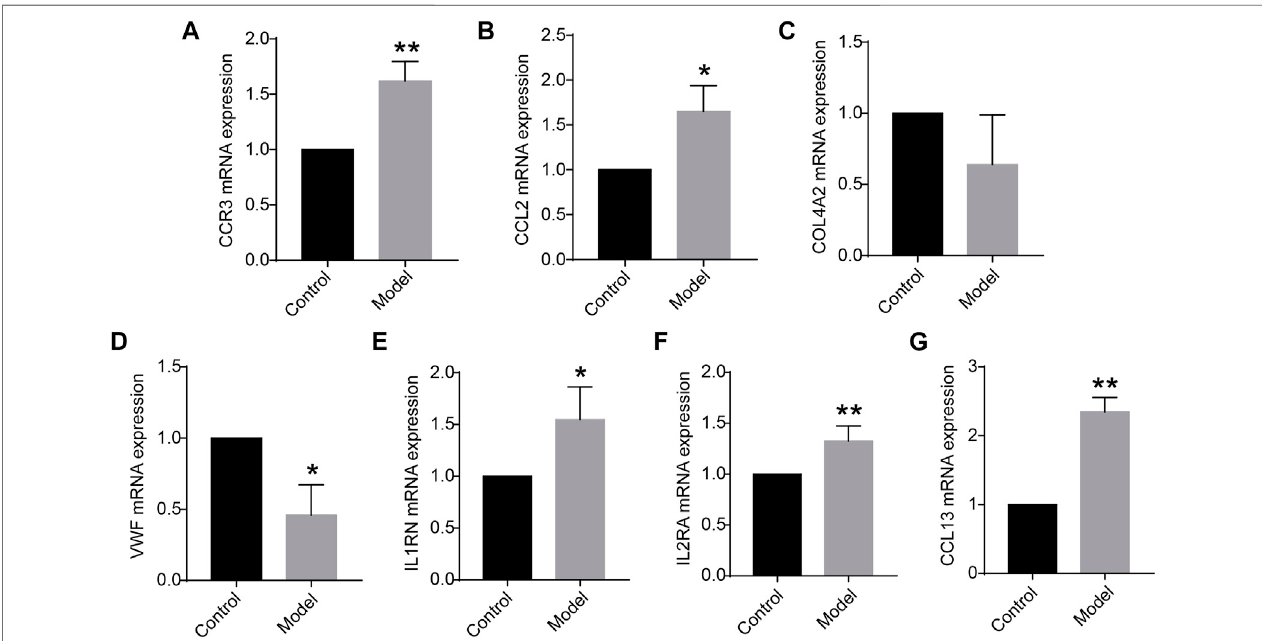
FIGURE 3 | (A – G) Messenger RNA (mRNA) expression levels of CCR3 , CCL2 , COL4A2 , VWF , IL1RN , IL2RA , and CCL13 in the lung tissue ( n (cid:2) 5 for each group) vs. control. Data are expressed as mean with SD. * p < 0.05 and ** p < 0.01 vs. the control group.